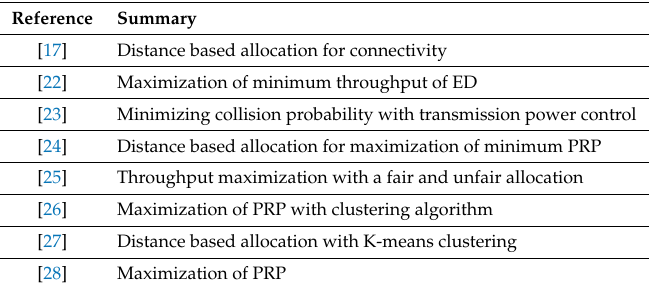
Table 1. Summary of existing